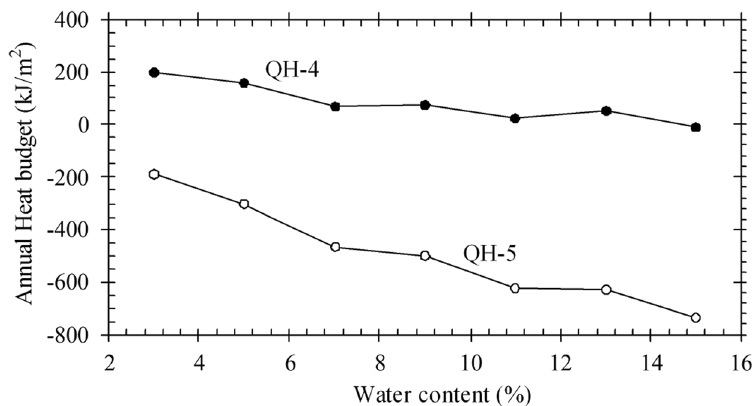
Figure 5. Calculated annual budget of the heat entering the sand layer at depths from 5 cm to 50 cm at sites QH-4 (30 cm sand layer) and QH-5 (115 cm sand